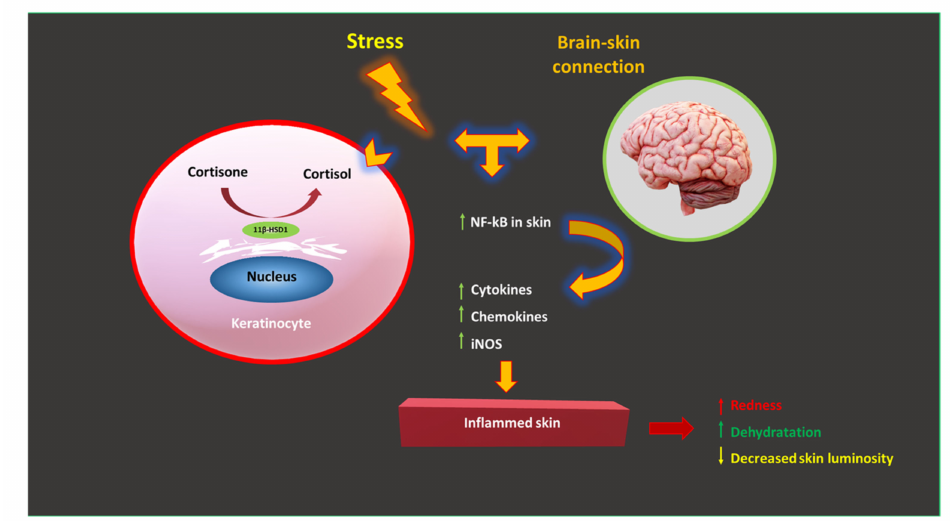
Figure 2. Diagram of the stress